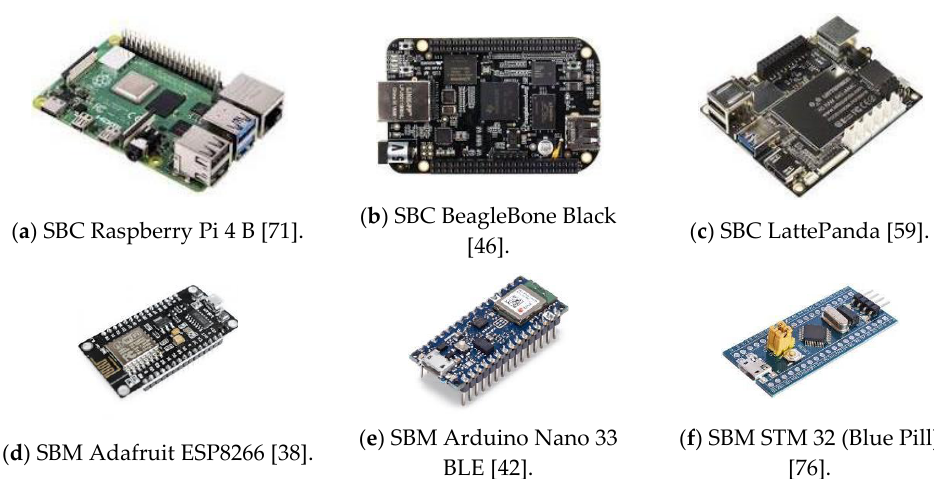
Figure 4. Low-cost Single Boards analyzed in experimental framework.